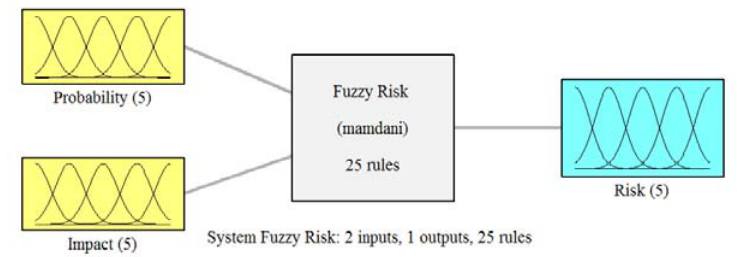
Fig. 4. Structure of the fuzzy model